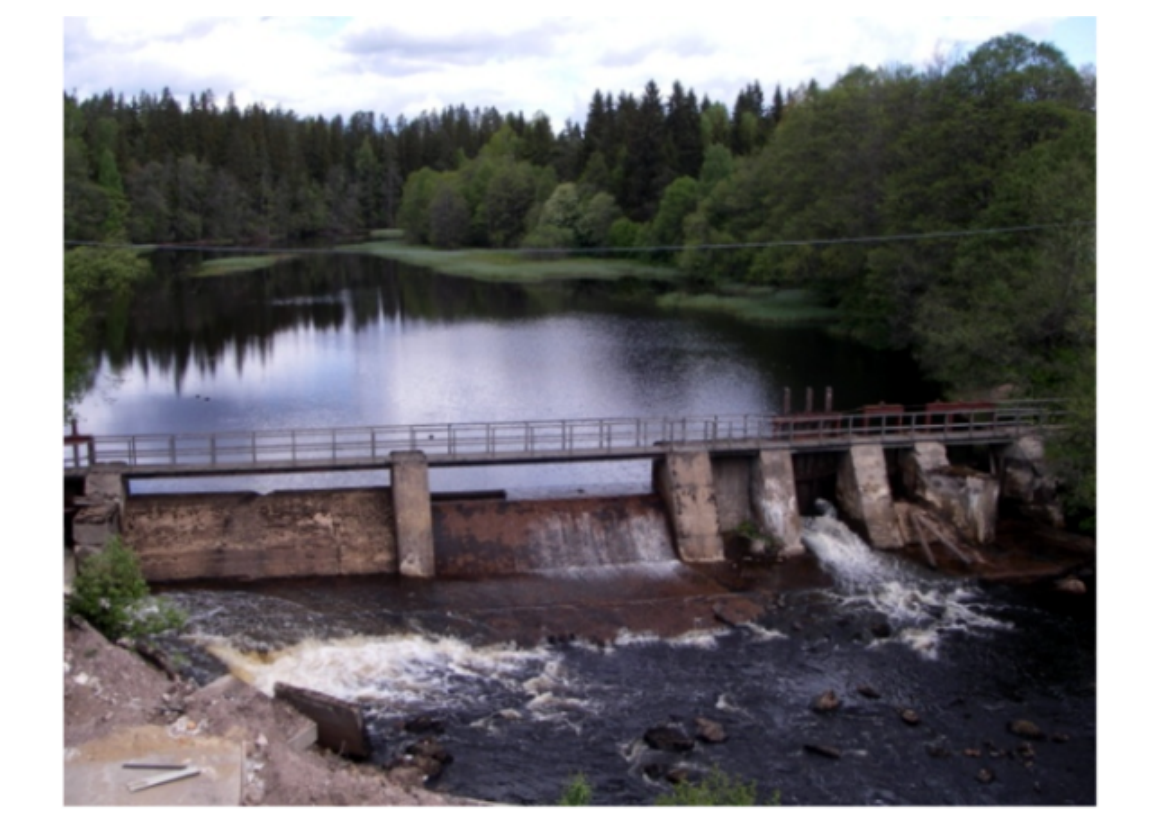
Fig. 3 . Unnefors Dam on the Nissan Stream before